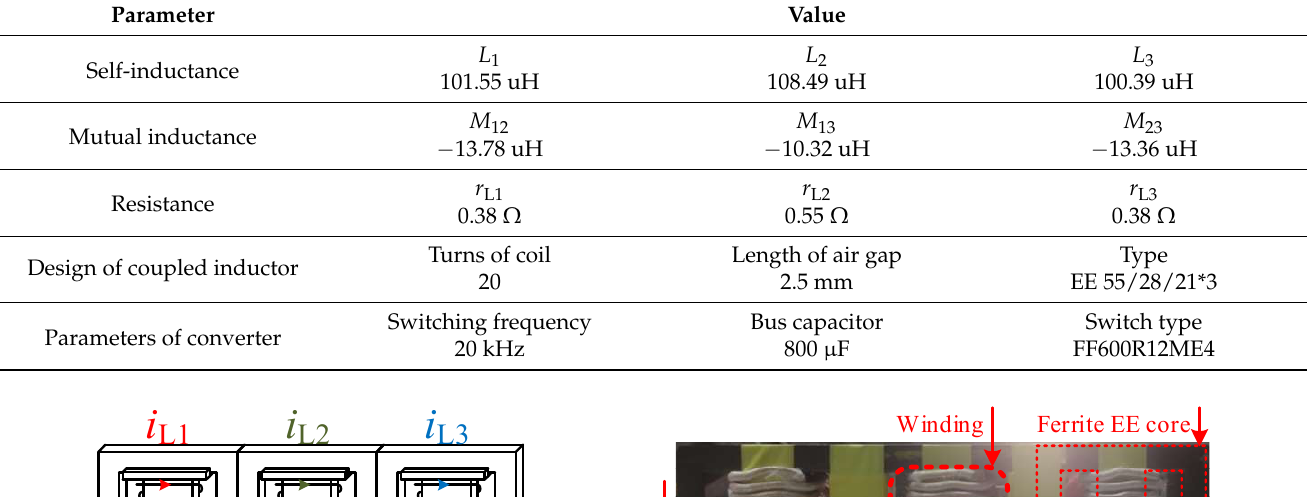
Table 3. Parameters of a 3-phase coupled buck–boost converter.